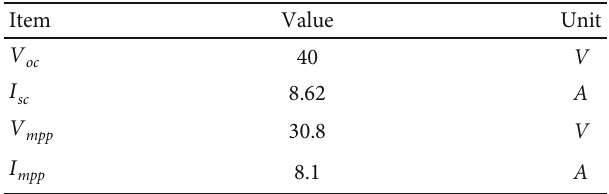
Table 4: Measured electrical characteristic of constructed panel simulator.